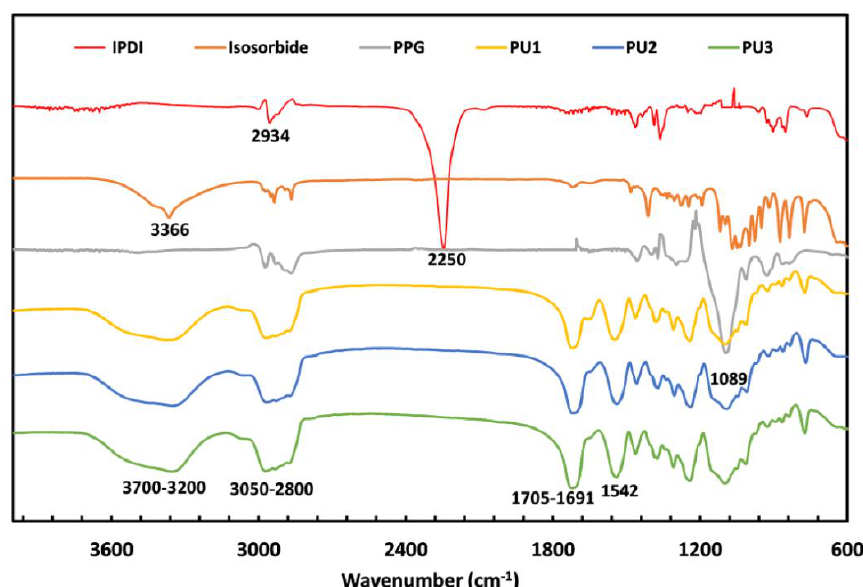
Figure 4. The FTIR spectra of the monomers Isosorbide, PPG, IPDI, and of the polyurethanes PU1 - PU3 .